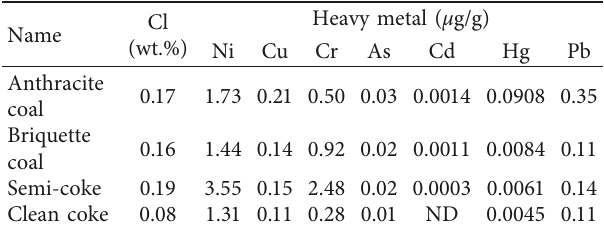
Table 3: The contents of Cl and heavy metals in several typical coal- based fuel